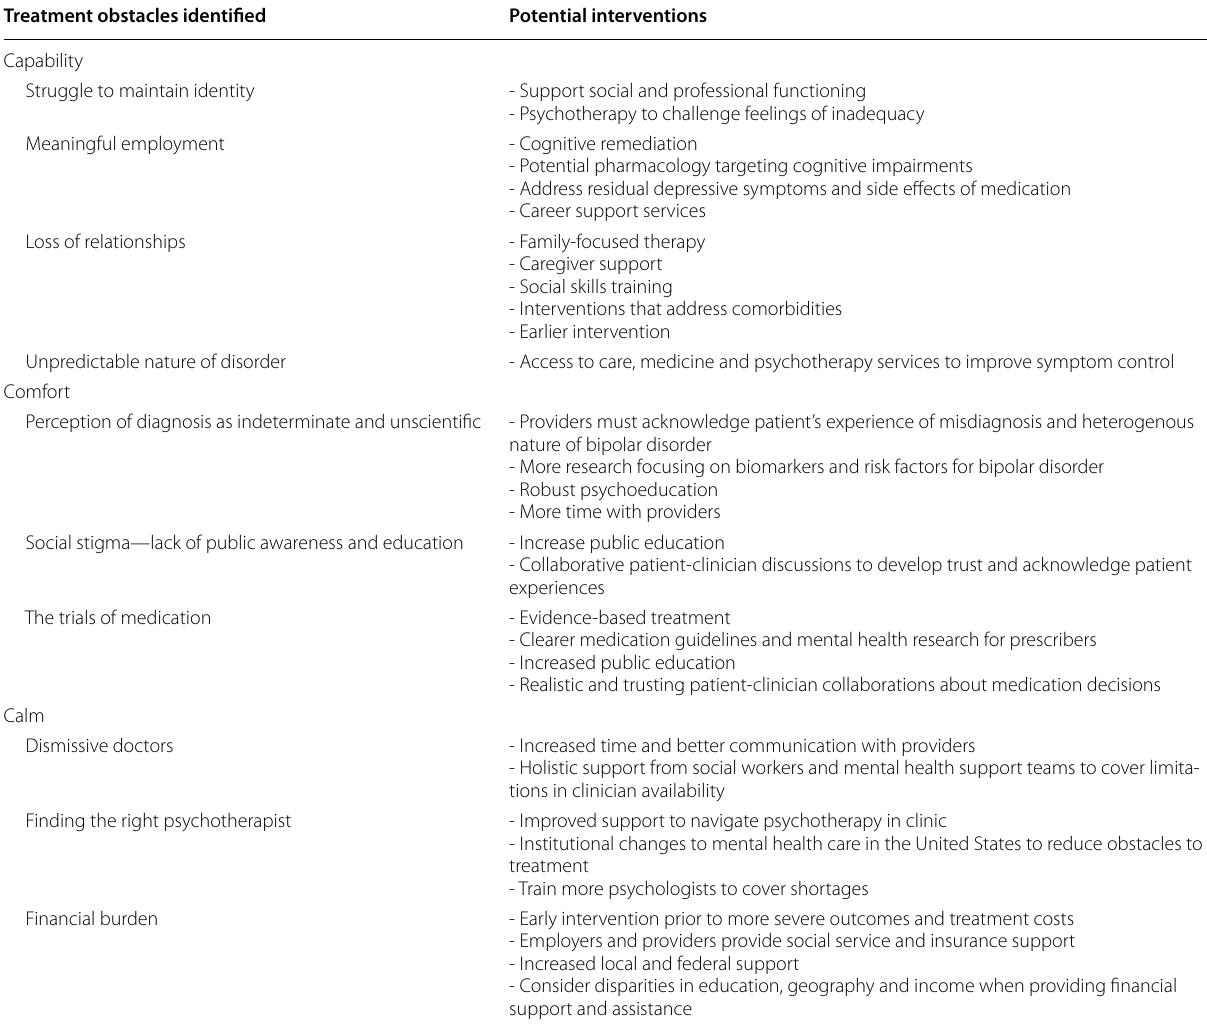
Table 1 The CCC framework with interventions Treatment obstacles